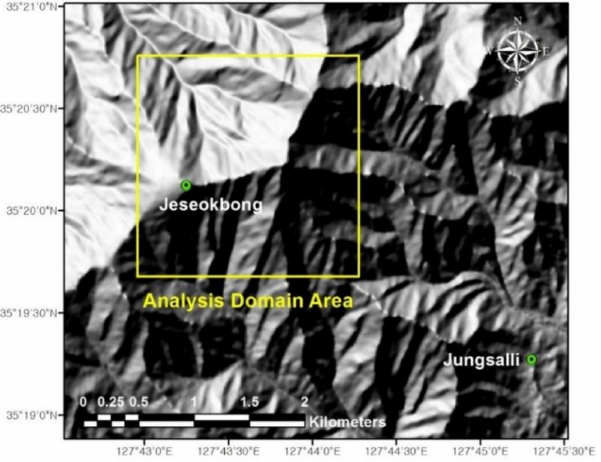
Figure 7. Landslide monitoring stations in Jirisan National Park and the analysis domain